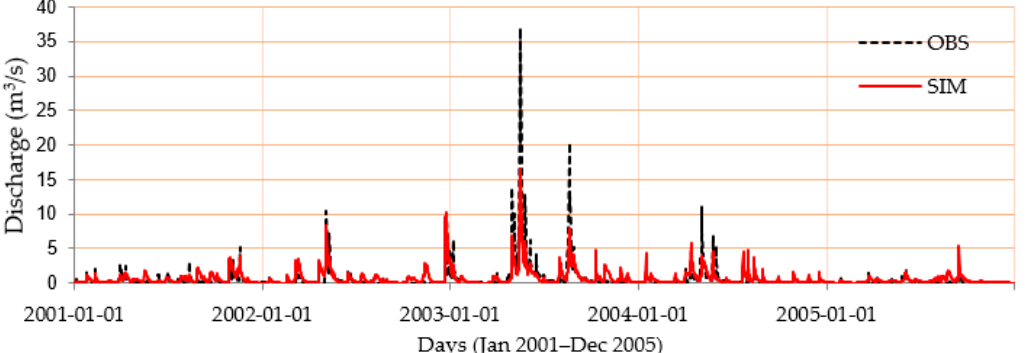
Figure 8. ( a ) Observed and simulated daily discharge for River Njoro (2FCO5) during the calibration period 1984–1996, ( b ) a section of observed and simulated daily flow for the calibration period 1989–1993, and ( c ) a section of observed and simulated flow for the validation period 2001–2005.